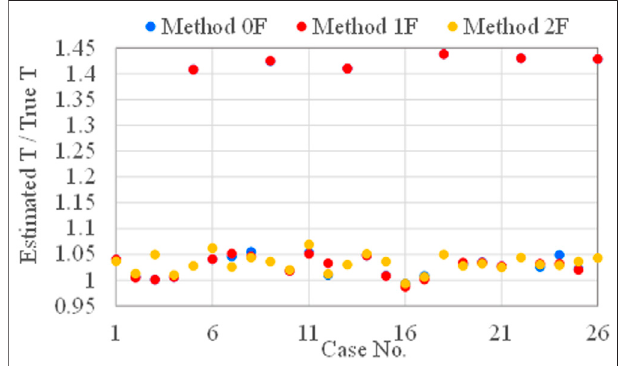
FIGURE 7 | Tension estimation